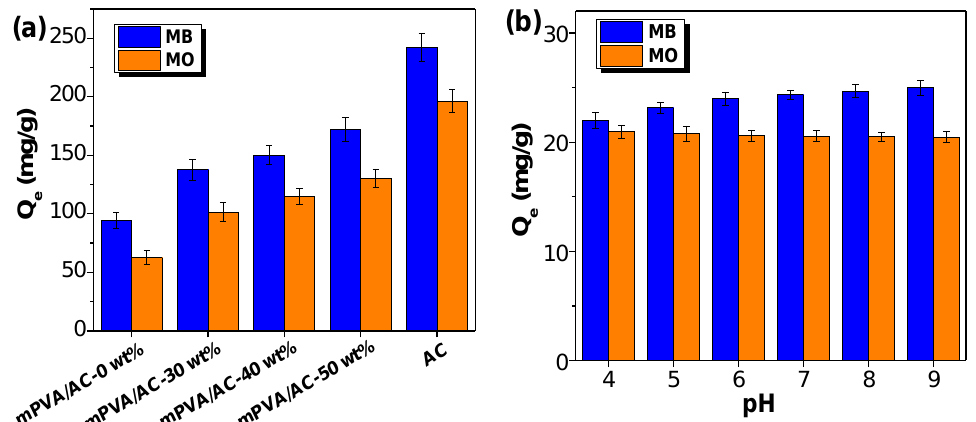
Figure 5. ( a ) Adsorption capacities of AC and mPVA/AC CG samples with different content of AC for adsorption of MB and MO. The initial dye concentration was 5 mM. ( b ) Effect of solution pH on the adsorption of MB and MO by mPVA/AC CG. The initial dye concentration was 0.1 mM. Since the interactions between dye molecules and adsorbent are heavily affected by solution pH [24,25], the effect of pH on the adsorption performance of mPVA/AC CG was assessed in the pH range of 4 – 9. As depicted in Figure 5b, the variation of solution pH has slight influence on the adsorption capacity of mPVA/AC CG towards both MB and MO.